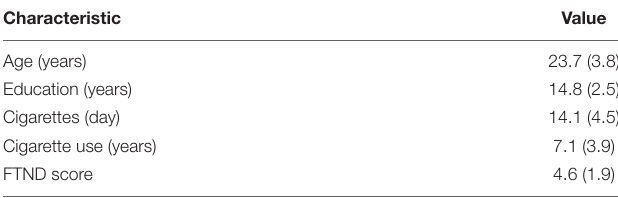
TABLE 1 | Demographic information of 28